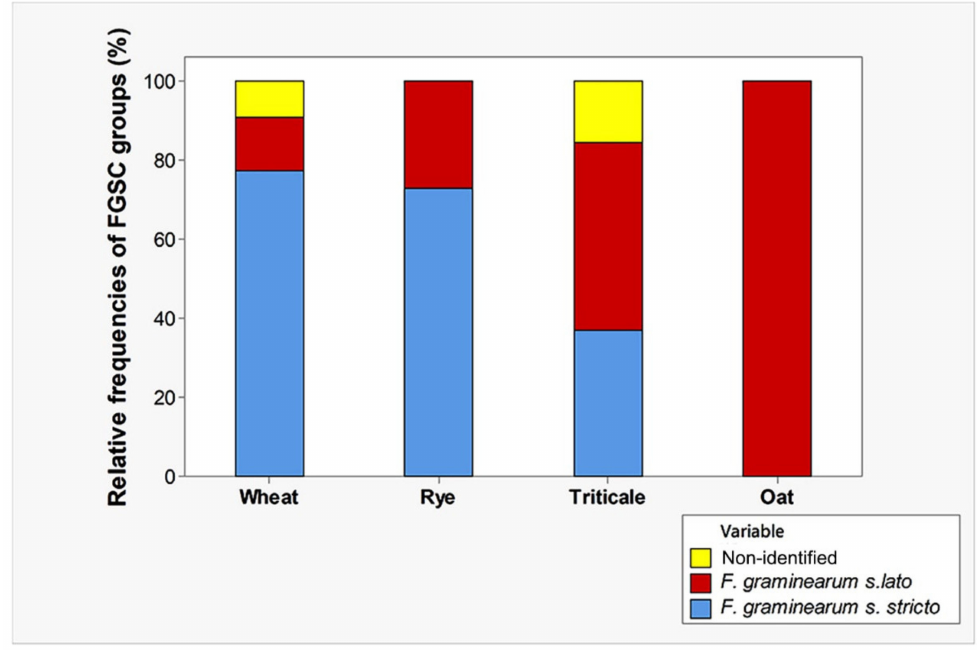
Figure 4. Associations among wheat, rye, triticale, oat and F. graminearum species complex (FGSC) groups.